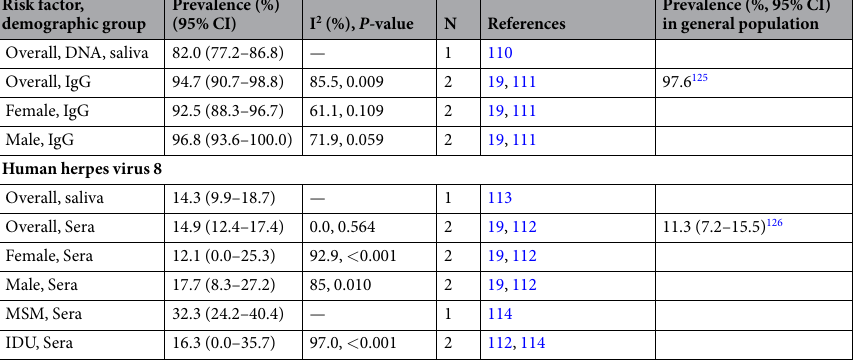
Table 3. Pooled and single prevalence of cancer risk factors among persons living with HIV/AIDS by demographic group and prevalence in general population, in China. a ‘Overall’ means PLWHA were not restricted by sex or HIV transmission category. b ‘Male’ means PLWHA were not restricted by HIV transmission